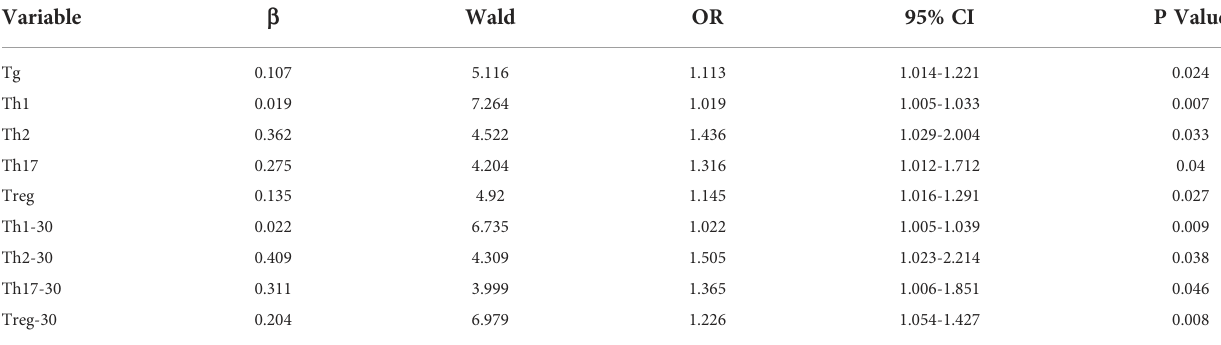
TABLE 2 Univariate analysis of prognosis in DTC patients.